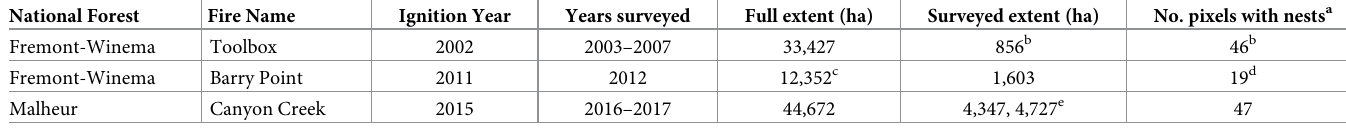
Table 1. Timing, size, and sampling of three Oregon wildfires where white-headed woodpecker nests were located to develop and evaluate habitat suitability models.